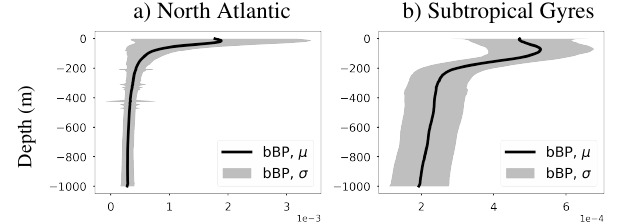
Figure 3. The BGC-Argo measured b bp profiles for the training dataset. The figure shows the mean and variance of the b bp values vs. the depth (m) for the a) North Atlantic and b) Subtropical Gyres.